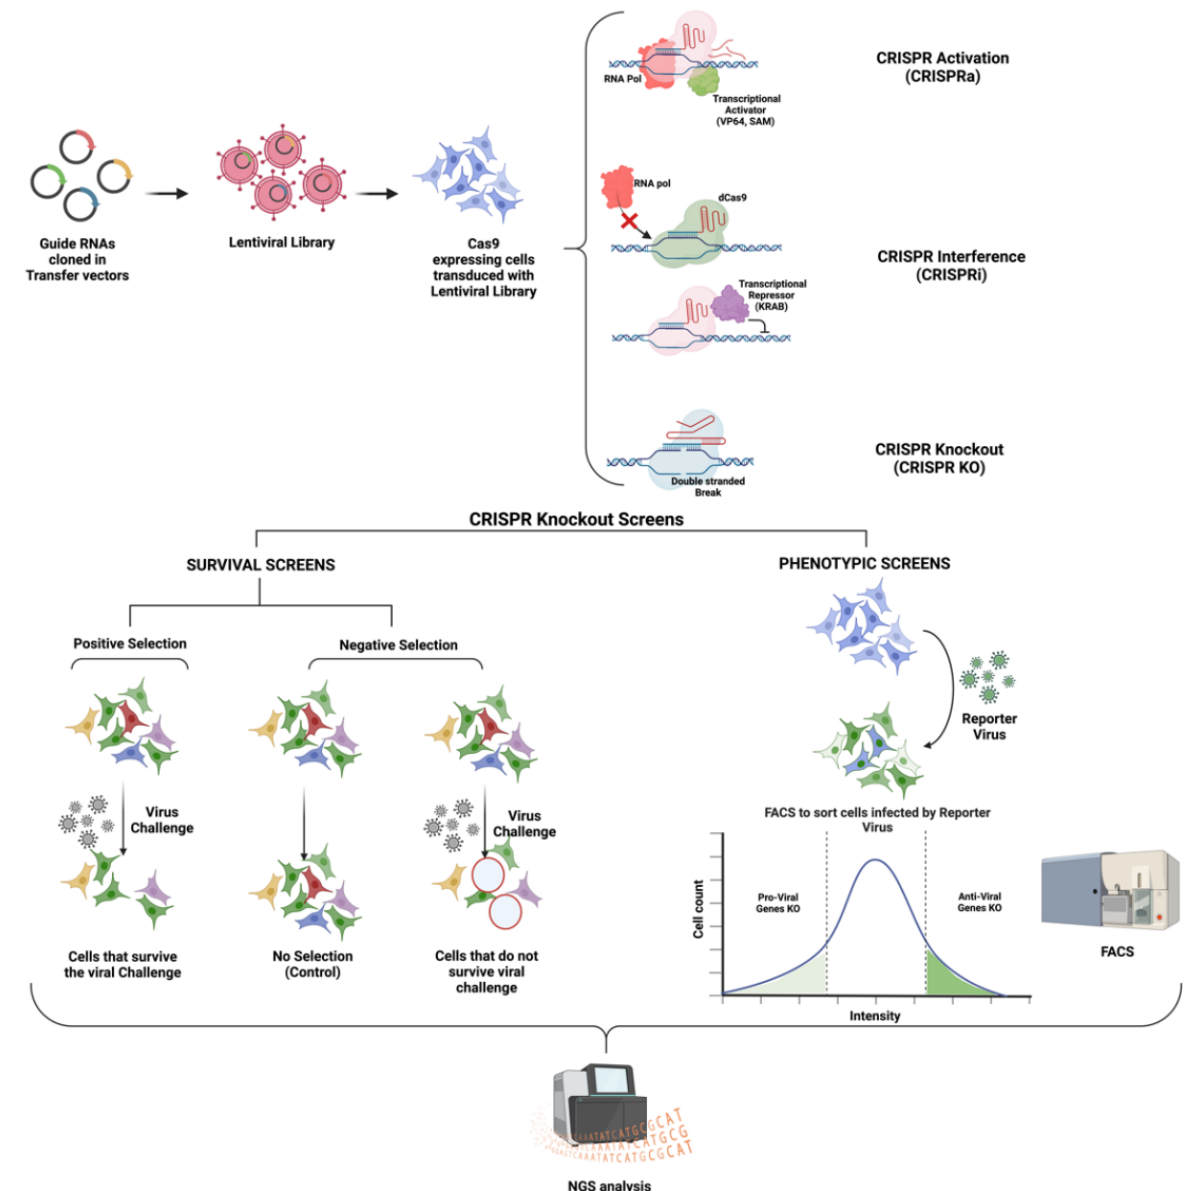
Figure 1. Schematic of different types of CRISPR Screens to identify virus-host interactions (Created with BioRender.com).